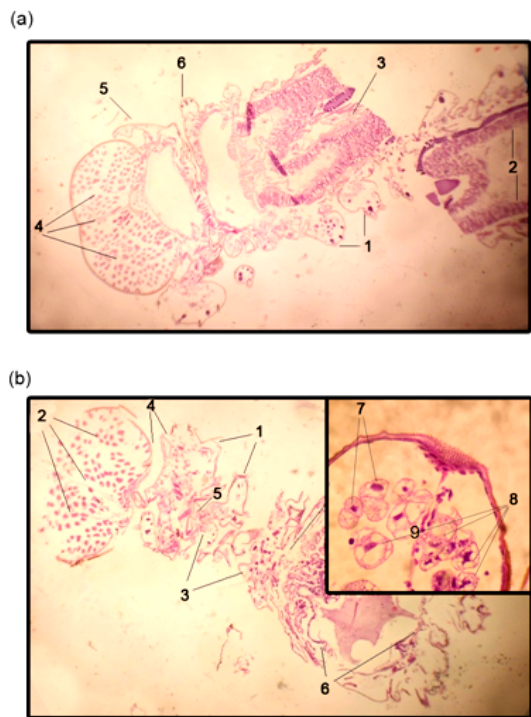
Figure 3. Light microscopy of the gypsy moth larvae histological slides. ( a ) Control sample